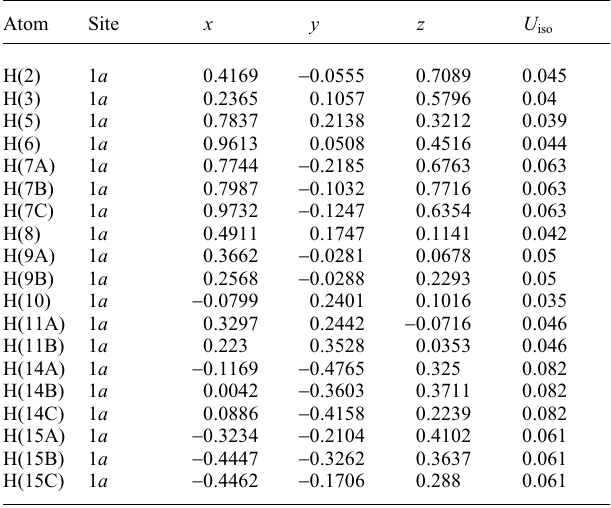
Table 2. Atomic coordinates and displacement parameters (in Å 2 )